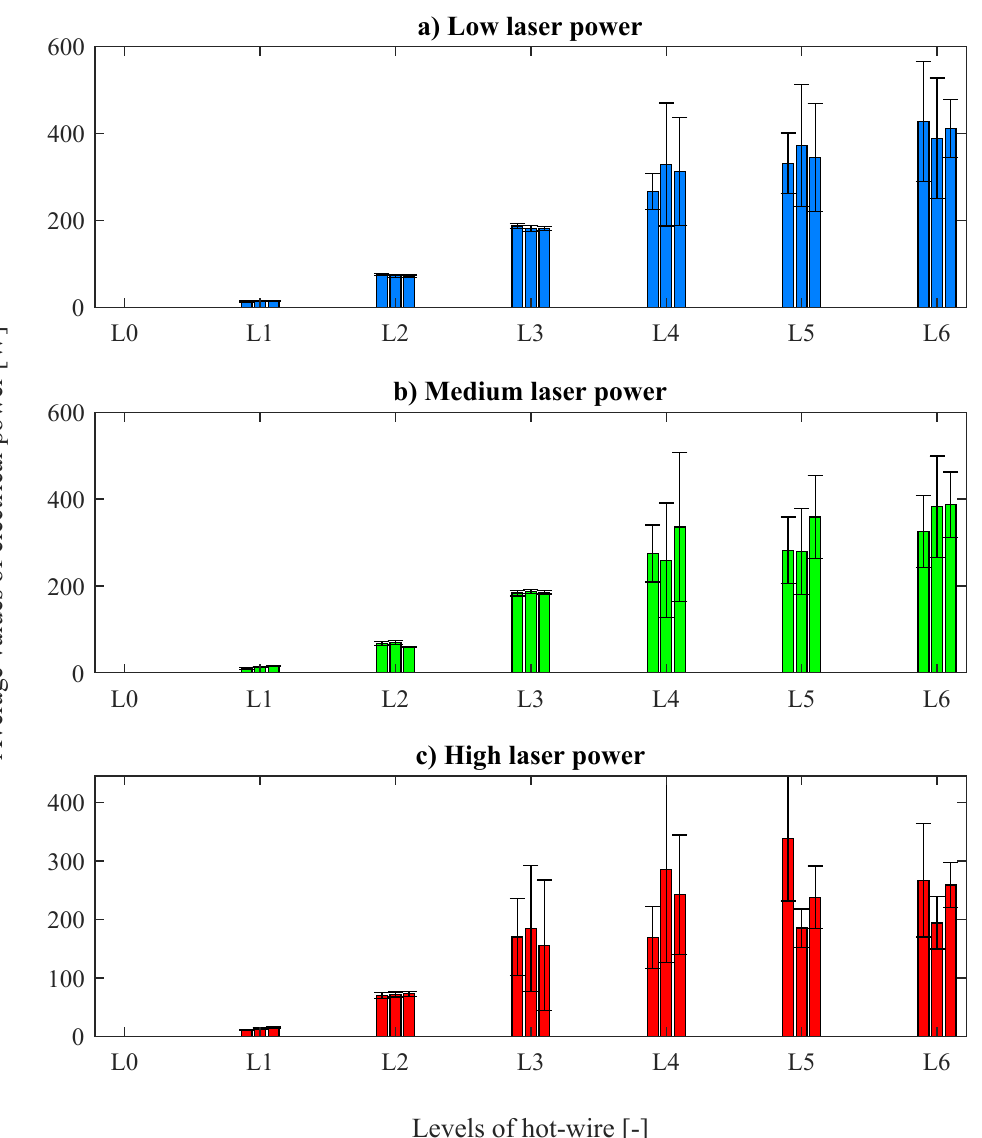
Figure 5. The average electrical power relative to each hot-wire level: ( a ) low laser power, ( b ) medium laser power, ( c ) high laser